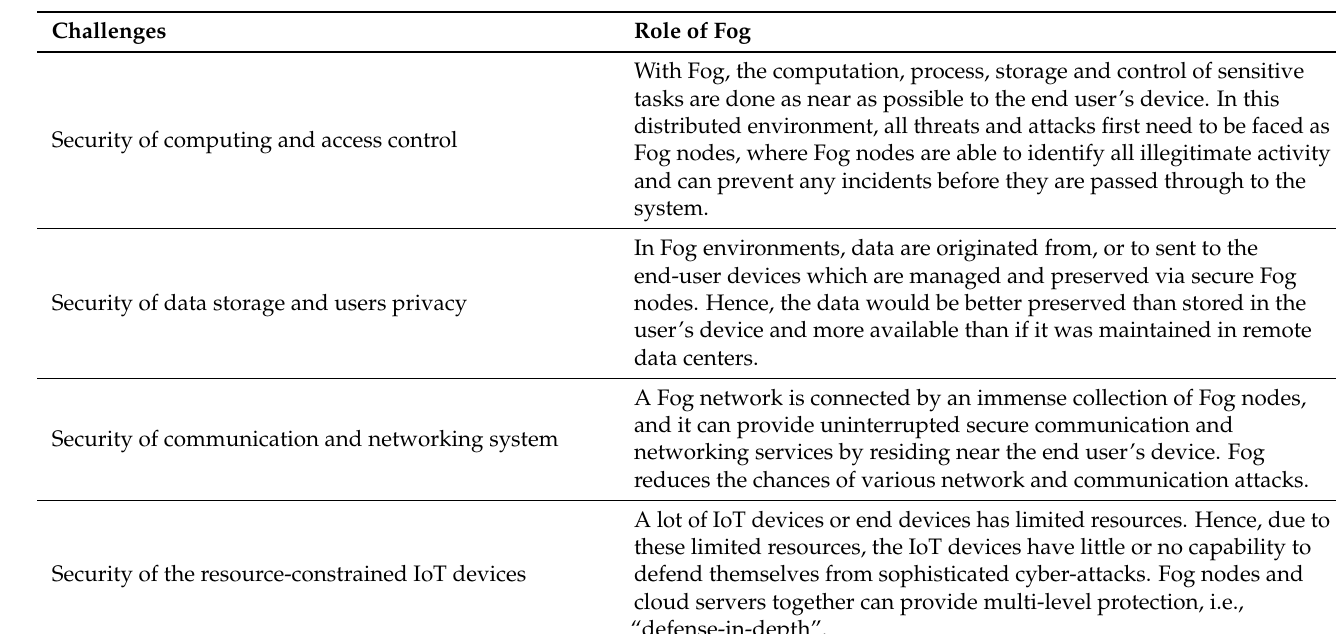
Table 5. Security challenges at